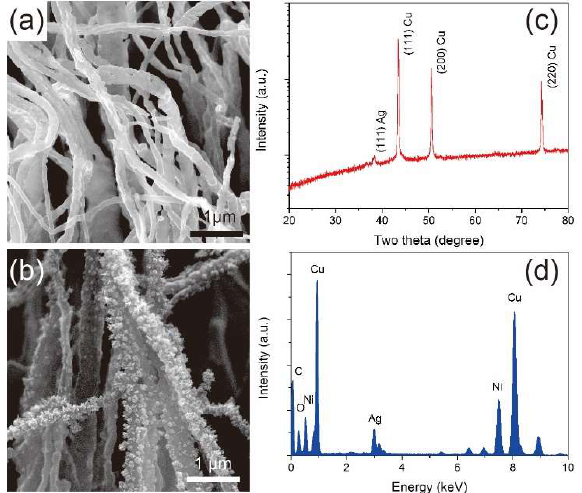
Figure 4. High-magnification SEM images of ( a ) thermally reduced Cu NWs, and ( b ) as-synthesized